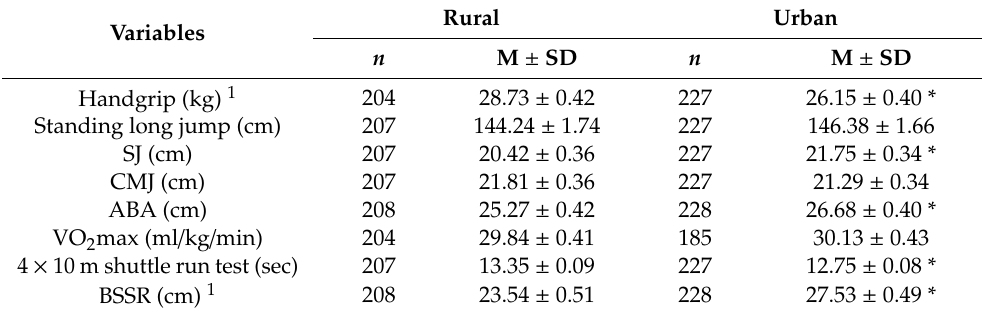
Table 2. Descriptive statistics and results of physical fitness ANCOVAs in rural and urban adolescents. Variables